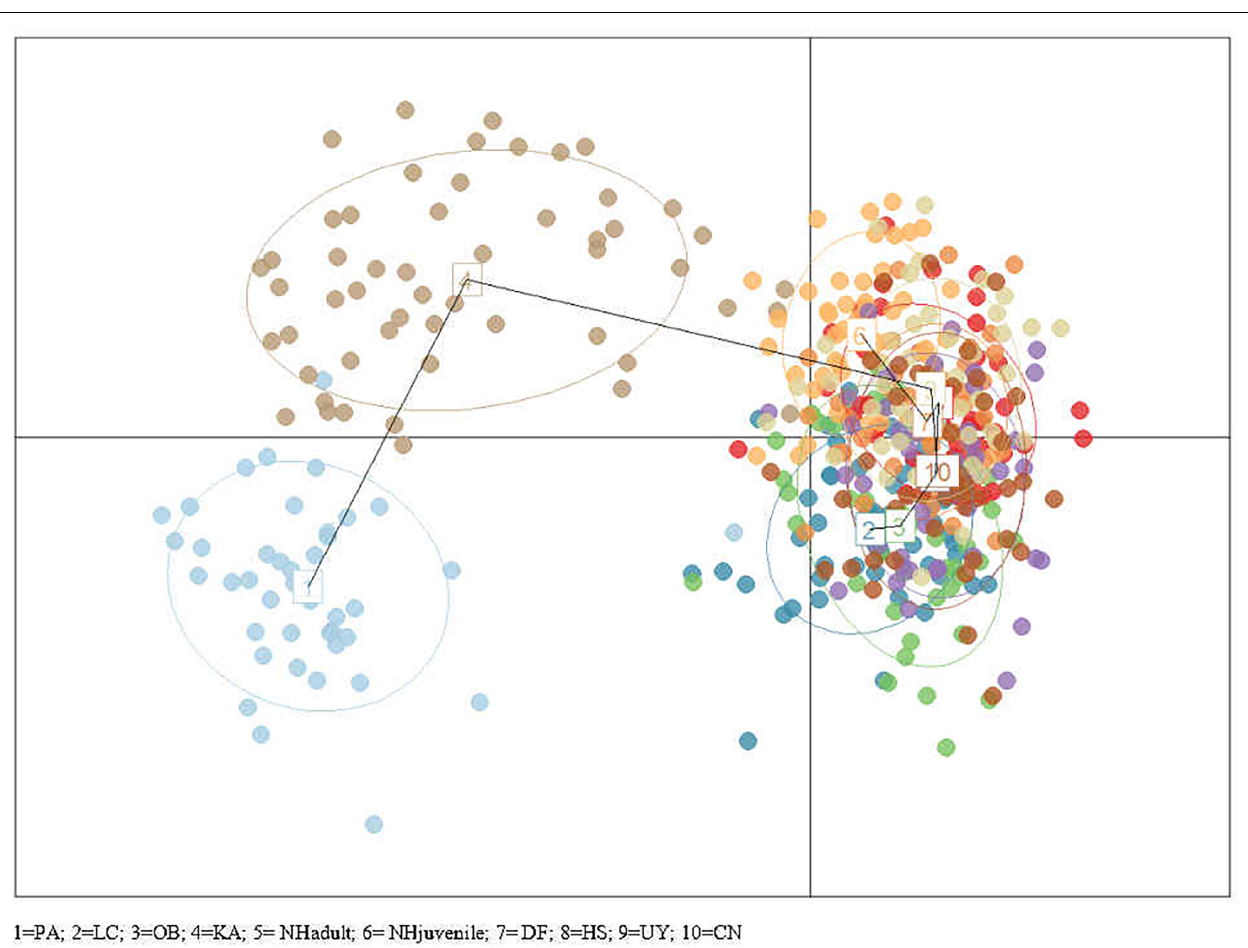
FIGURE 5 | Plot of DAPC for groups defined by sampling locations. A single dot represents an individual. Population centers are indicated by population number (1–10) and are connected by a minimum spanning tree.